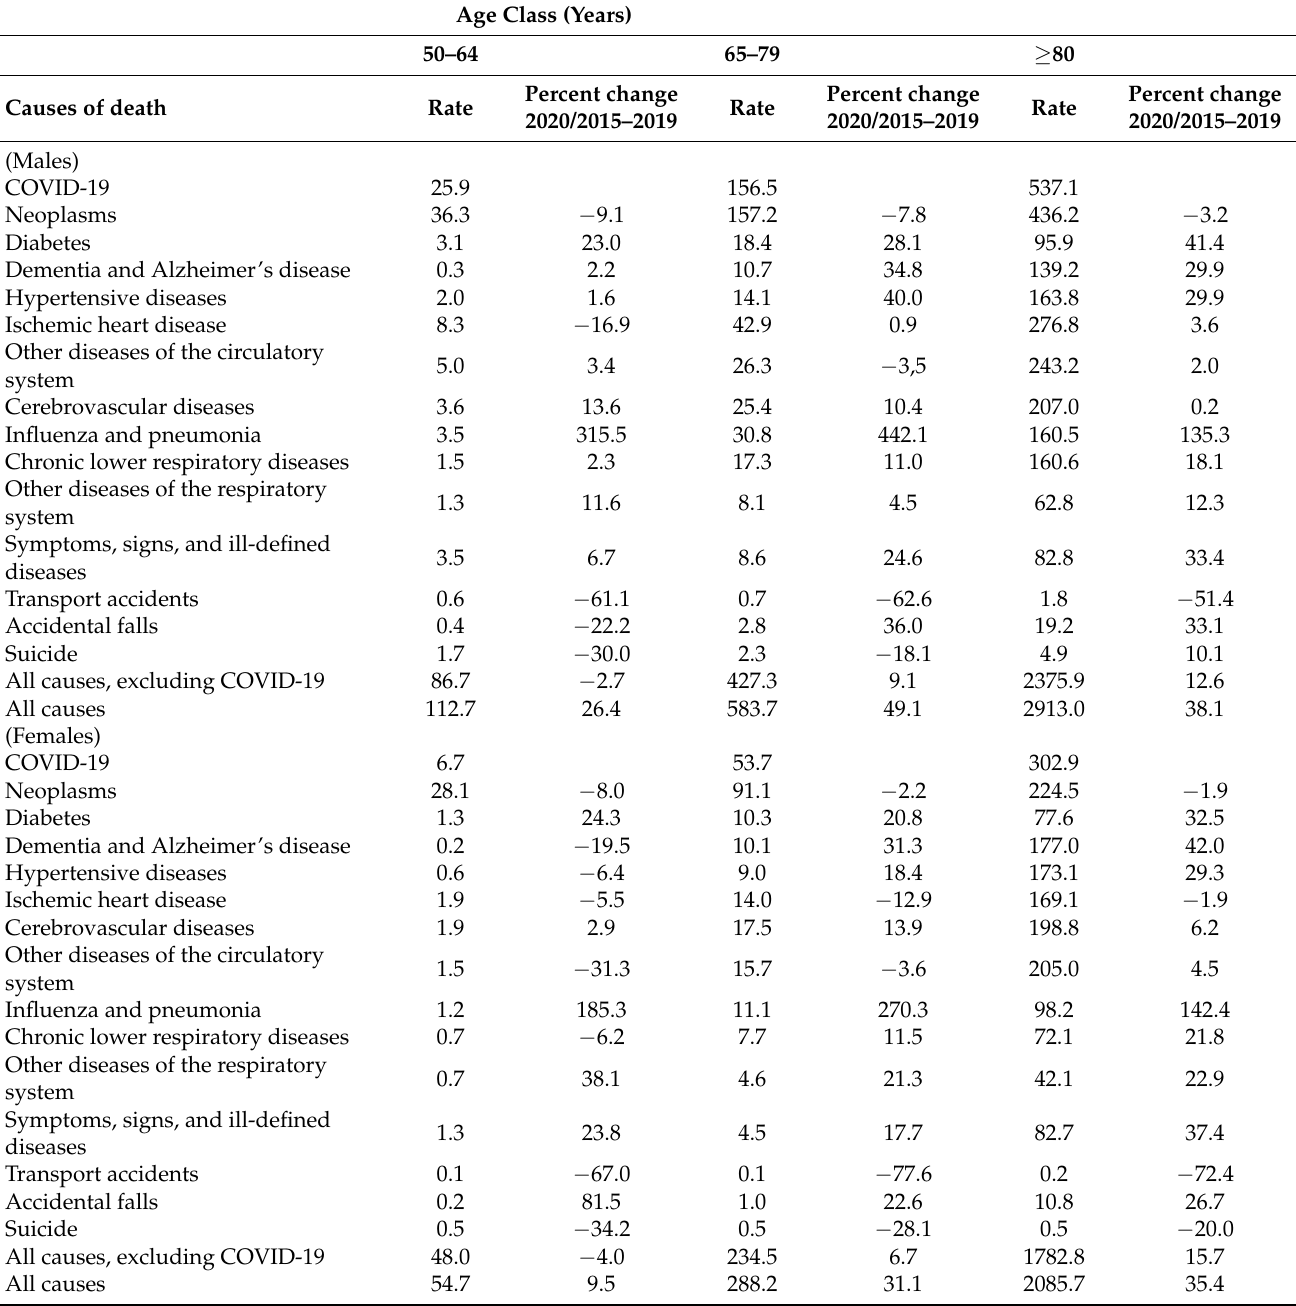
Table 2. Mortality by cause in Italy from March 2020 to April 2020 by sex and age class (50 years and above): age-standardized mortality rates (per 100,000 residents) and percent change in rates compared with those in